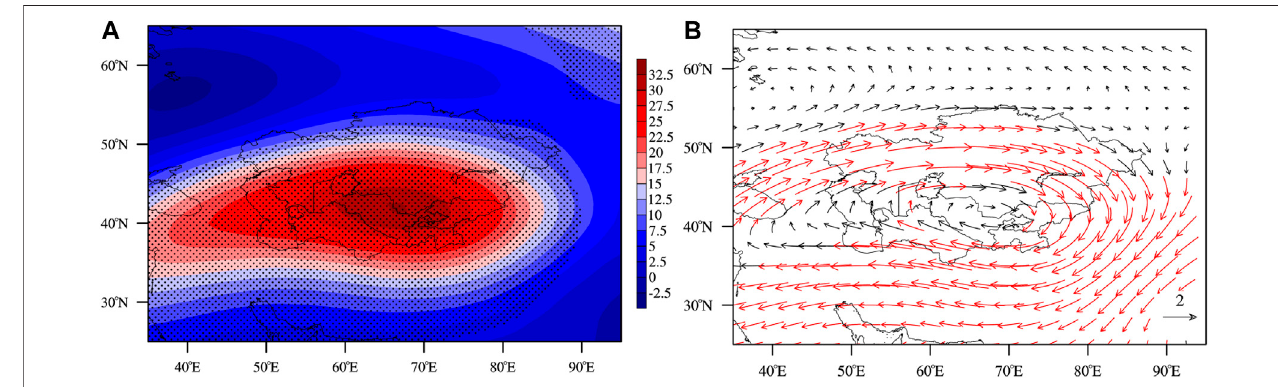
FIGURE 10 | (A,B) show the regression coef fi cients of MUTTI for geopotential height and wind fi eld of 200 hPa, respectively. The dotted area in (A) and the red wind fi eld in (B) show the area that passed the 90% con fi dence level student ’ s t-test.